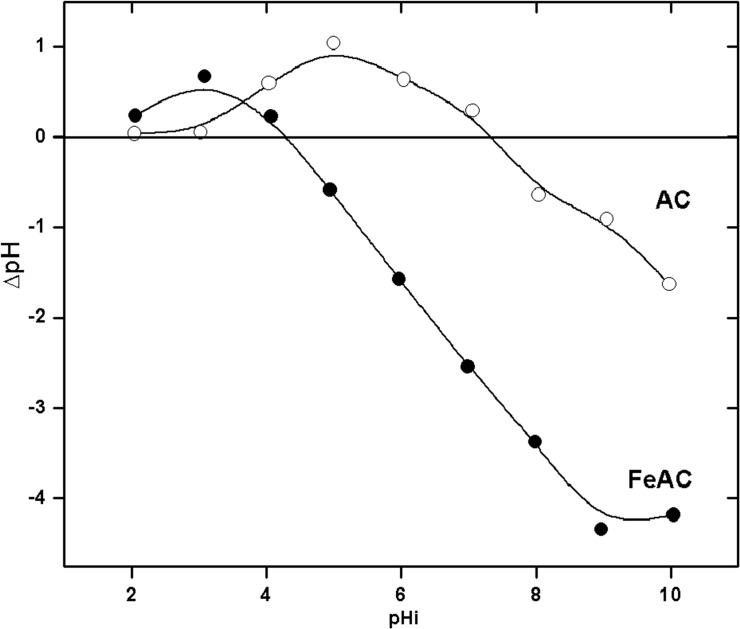
Determination of the pH of zero point of charge (pHZPC) for AC and FeAC.